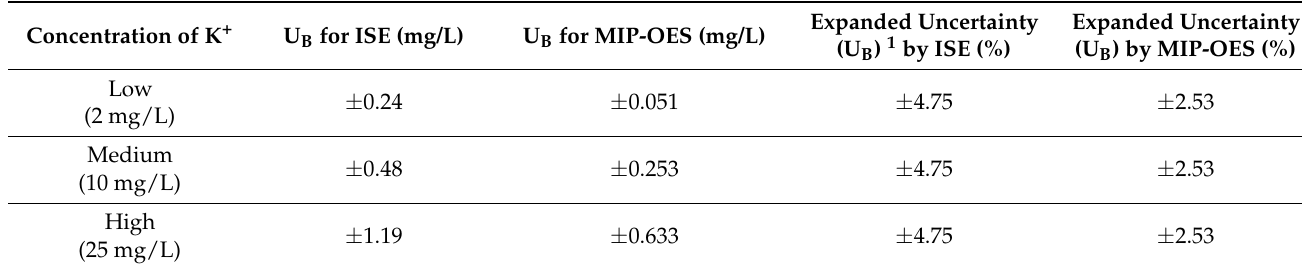
Table 8. Results of the B-type expanded uncertainty estimation for the determination of potassium ion concentration using ISE and MIP-OES methods.